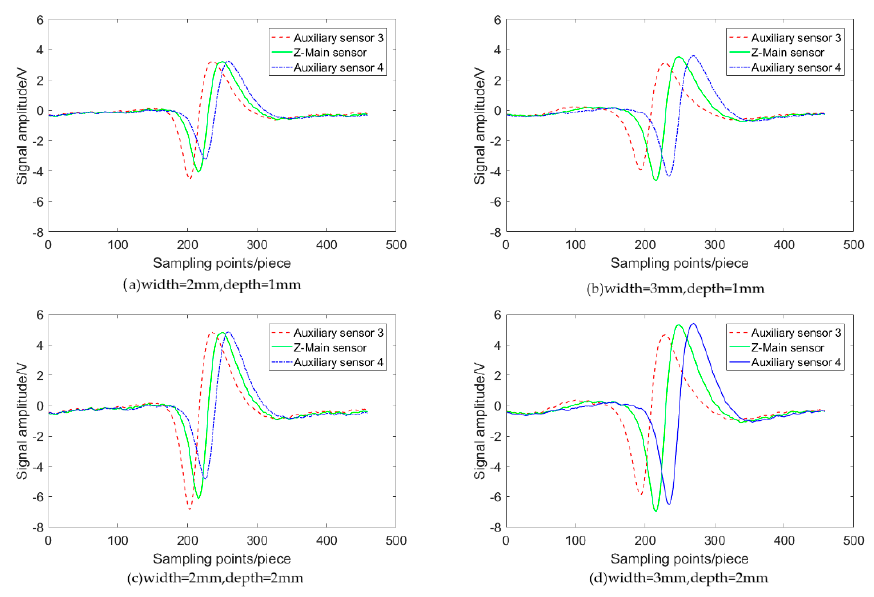
Figure 14. z -component results with different defects.